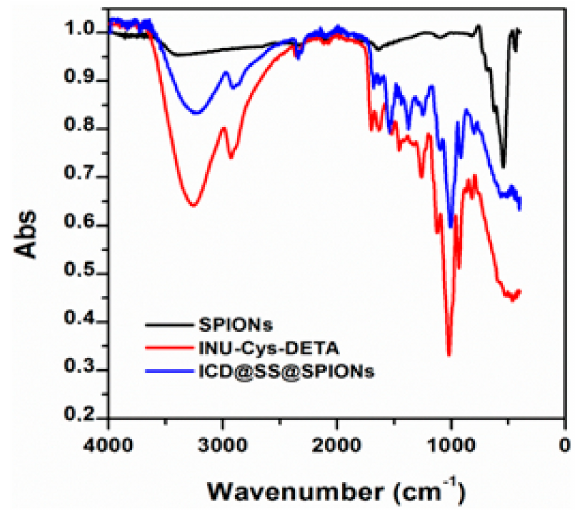
Figure 3. Fourier transform infrared (FT-IR) spectra of SPIONs, INU-C-DETA and ICD@SS@SPIONs.